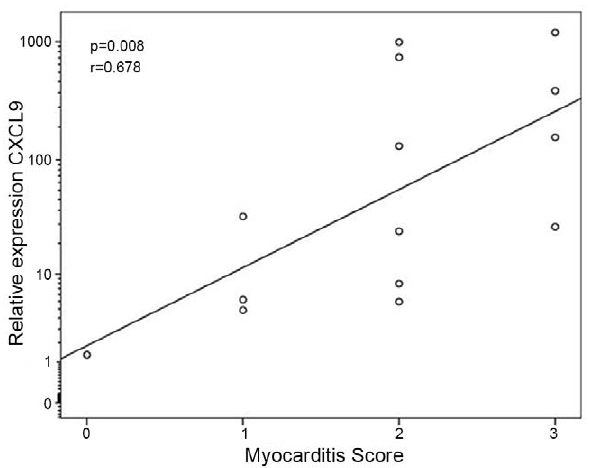
Figure 3. Correlation between histopathologically assessed intensity of myocarditis and mRNA expression of CXCL9 in CCC myocardium. Two-tailed p value obtained with Spearman’s nonpara- metric correlation. n=14.